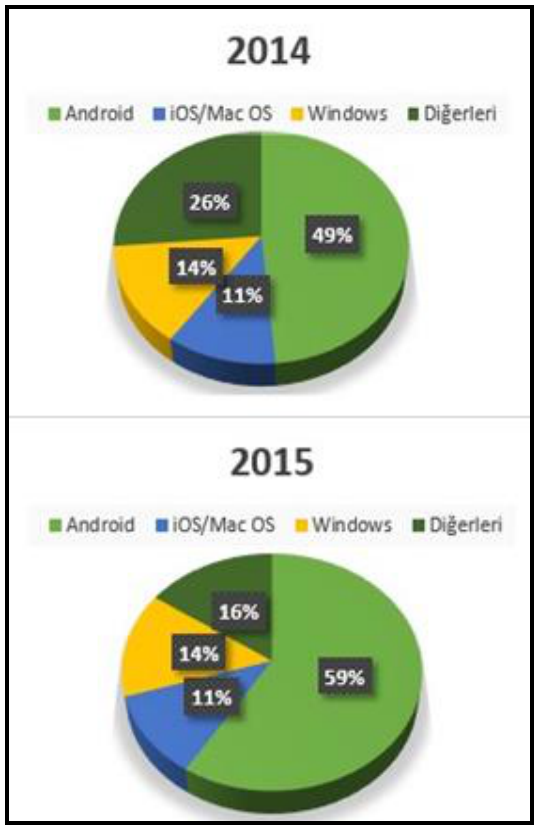
Figure 7. Android versions usage